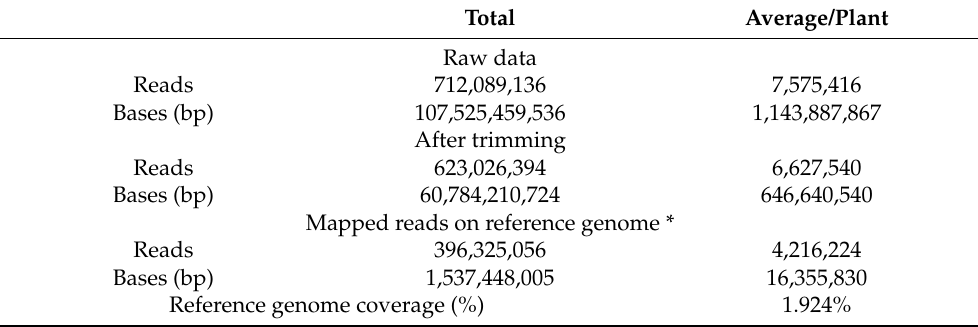
Table 2. Summary of GBS sequence data and alignment to the reference genome sequence.